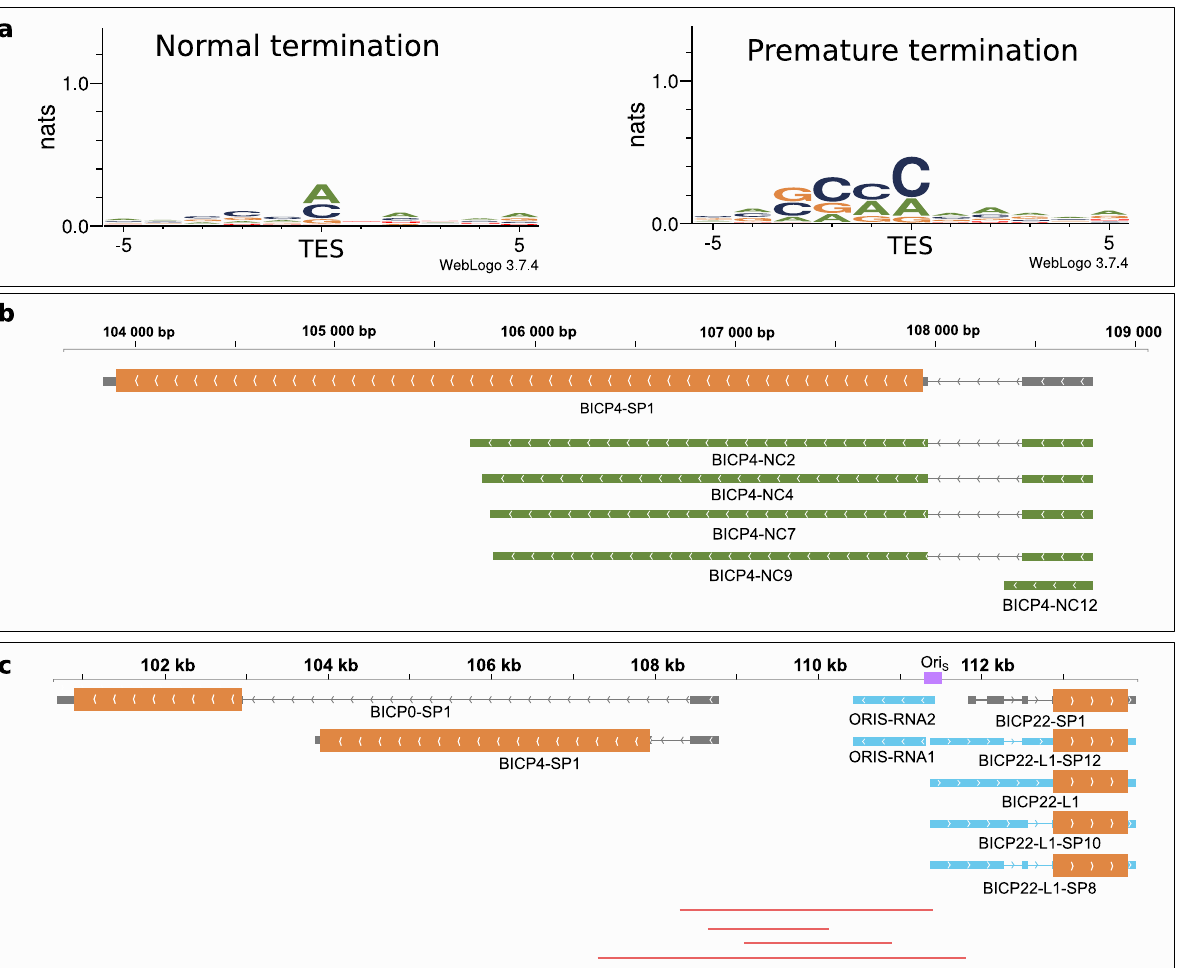
Figure 2. Non-coding transcripts and raRNAs of BoHV-1. ( a ) The ± 5 bp sequence surroundings of the most frequent TESs and the TESs of 3 ′ truncated transcripts. TESs of prematurely terminating transcripts are characterized by GC-richness immediately upstream of the cleavage site. The unit of entropy is based on natural logarithm and is expressed in natural units of information (nats). ( b ) Grey rectangles represent coding transcripts. The wider overlapping orange rectangle is the ORF. Lines between the rectangles represent introns. The orientation of transcripts is represented by arrow heads. Green rectangles represent 3 ′ truncated transcripts. Five 3 ′ truncated transcripts were detected overlapping the bICP4 gene. ( c ) Grey rectangles represent transcripts located close to the Ori region. The wider overlapping orange rectangles are ORFs. Lines between the rectangles represent introns. The orientation of the transcript is represented by arrow heads. Light blue rectangles